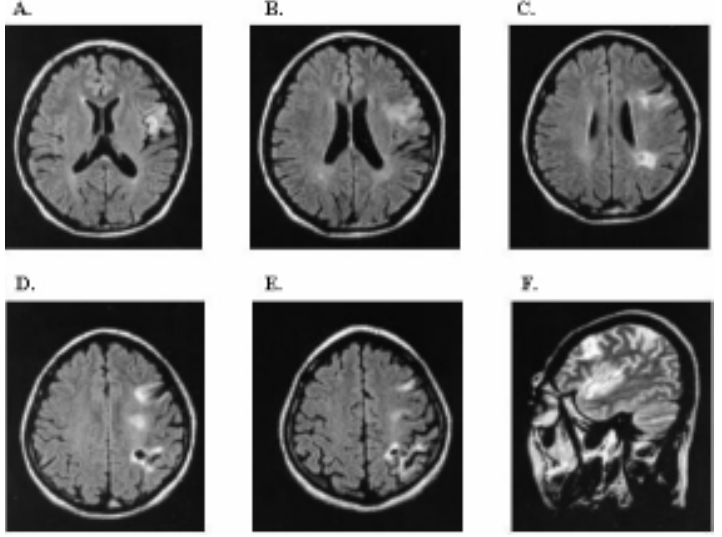
Fig. 2. The Axial FLAIR ( A ∼ E ) and sagittal T2 weighted ( F ) Brain MRI demonstrating high signal abnormalities involving the left premotor area (Brodmann area 6), insular cortex and superior parietal